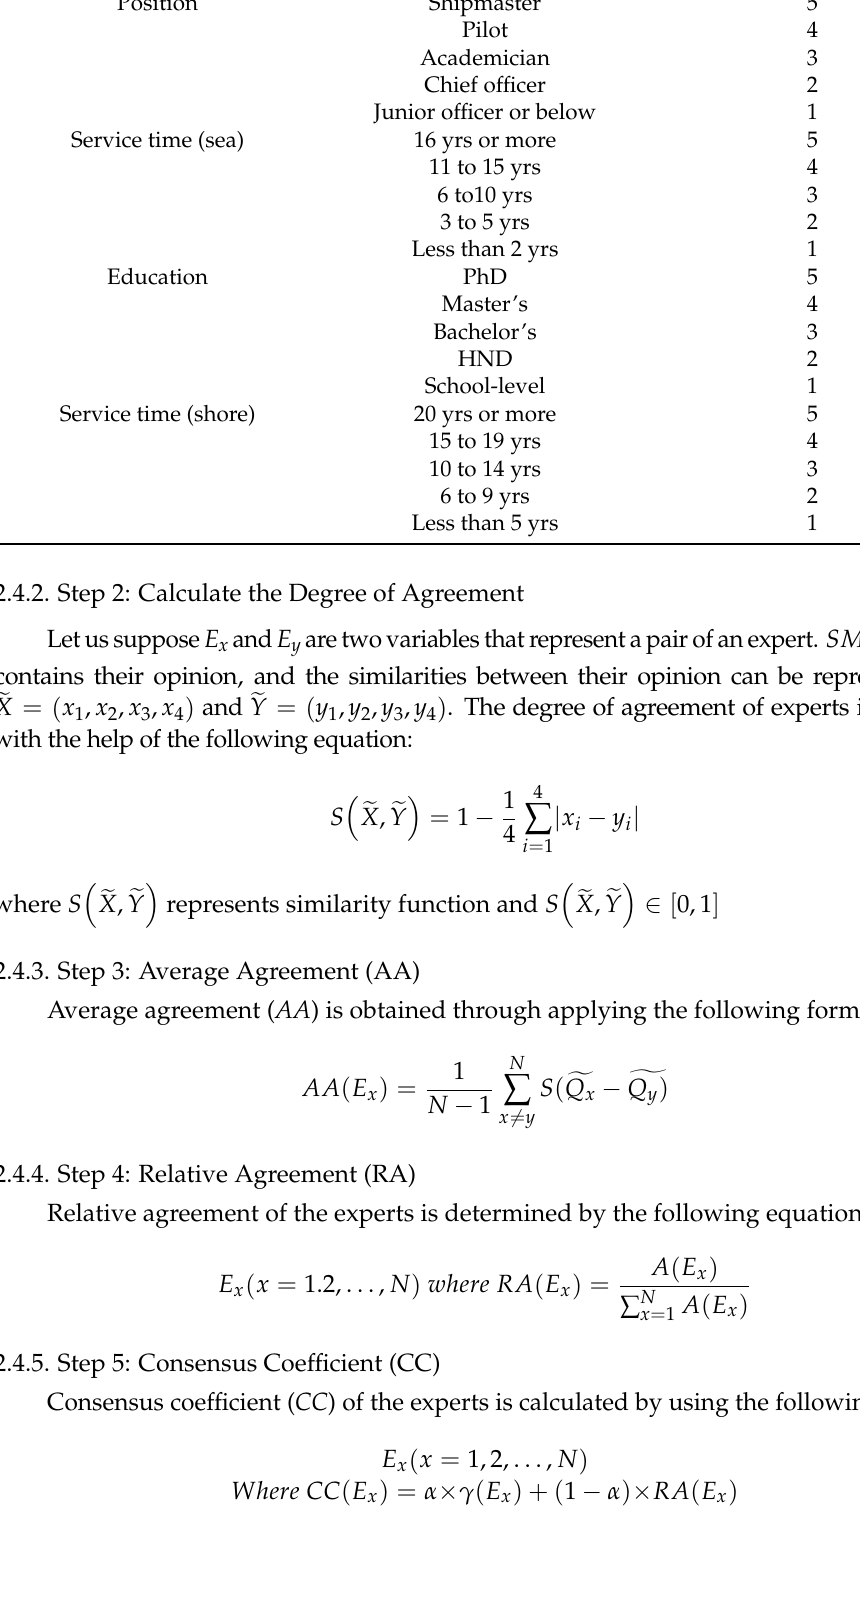
Table 1. Expert weightage according to their credentials.